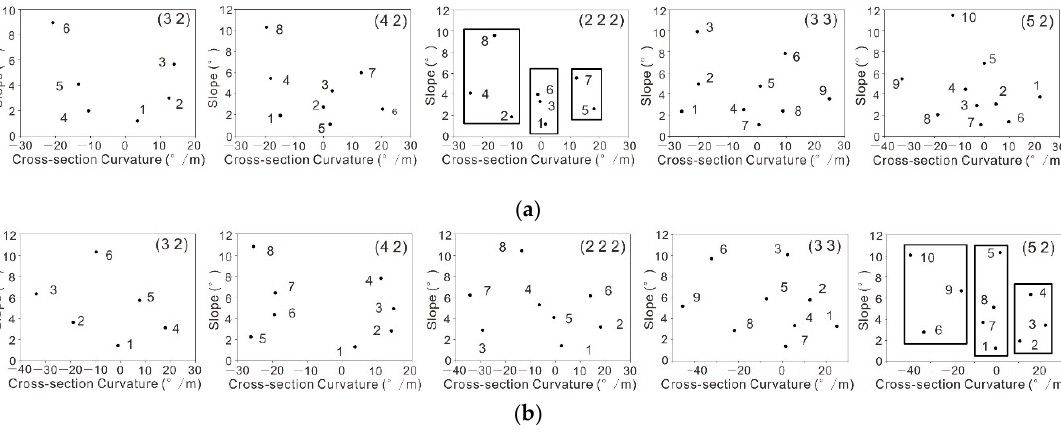
Figure 4. Distribution of map units in the feature space with different numbers and arrangement map units using the self-organization map (SOM) technique for the sample data of ( a ) Chizhou Reach and ( b ) the Yangtze Estuary.